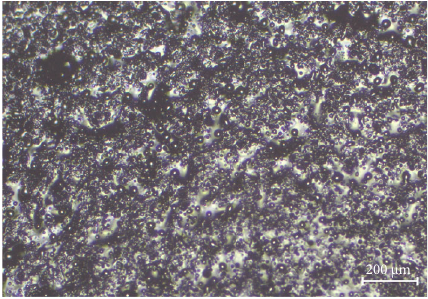
Figure 9: Metallographic diagram of CNT nanocomposite photothermal